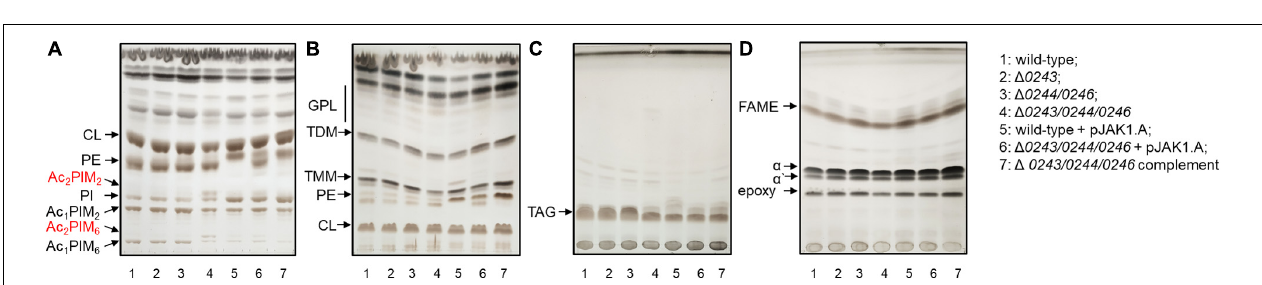
FIGURE 6 | Lipid and mycolic acids analysis of 1: wild-type; 2: (cid:49) 0243 ; 3: (cid:49) 0244/0246 ; 4: (cid:49) 0243/0244/0246 ; 5: wild-type + pJAK1.A; 6: (cid:49) 0243/0244/0246 + pJAK1.A; 7: (cid:49) 0243/0244/0246 complemented grown in Sauton’s medium at 37 ◦ C for 3 days. The lipids were separated in (A) solvent I; (B) solvent II; (C) solvent III and mycolic acids were separated in (D) solvent IV. The lipids were visualized with 10% CuSO 4 in 8% phosphoric acid solution and heating. Increase in amount of Ac 2 PIM 2 and Ac 2 PIM 6 was the only change that reproducibly correlated with the disruption of MSMEG _ 0243/0244/0246 and was restored in the complemented strain. CL, cardiolipin; GPL, glycopeptidolipids; PE, phosphatidylethanolamine; PIM, phosphatidylinositol mannosides; PI, phosphatidylinositol; TMM, trehalose monomycolates; TDM, trehalose dimycolates; TAG, triacylglycerols; FAME, fatty acid methyl esters; α , α ’ and epoxy refer to forms of mycolic acid methyl